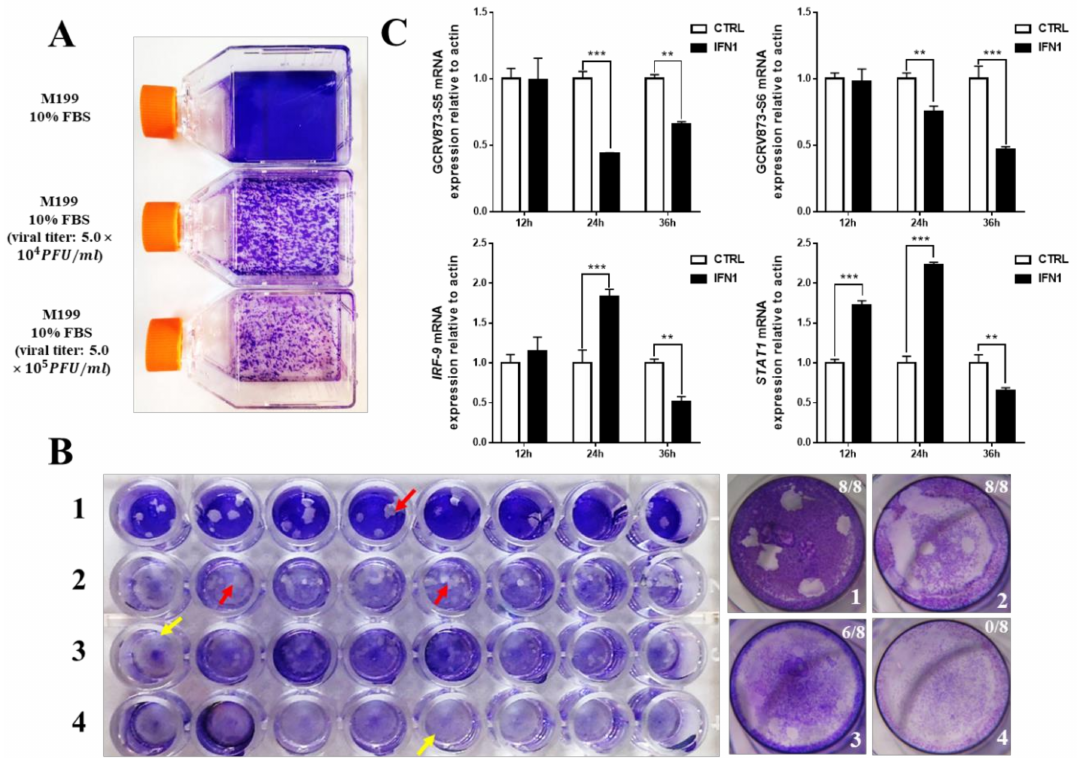
Figure 2. Antiviral ability of grass carp IFN1. ( A ) The pathogenicity of GCRV873 virus particles. The upper bottle contains M199 culture medium supplied with 10% fetal bovine serum; the middle bottle contains M199 culture medium supplied with 10% fetal bovine serum and GCRV873 virus particles at a final concentration of 5.0 × 10 4 PFU/mL; the lower bottle contains M199 culture medium supplied with 10% fetal bovine serum and GCRV873 virus particles at a final concentration of 5.0 × 10 5 PFU/mL. ( B ) The results of crystal violet staining of CIK cells in M199 medium supplied with or without GCRV873 virus particles. 1: CIK cells were infected with GCRV873 (viral titer: 1.0 × 10 2 PFU/mL); 2: CIK cells were electrically transfected with pCDNA3.1 and infected with GCRV873 (viral titer: 1.0 × 10 2 PFU/mL); 3: CIK cells were electrically transfected with pCDNA-IFN1-His and infected with GCRV873 (viral titer: 1.0 × 10 2 PFU/mL); 4: CIK cells were electrically transfected with pCDNA-IFN1-His and not infected with GCRV873. Red arrow: Plaques formed in cultured CIK cells. Yellow arrow: No plaques formed in cultured CIK cells. ( C ) The transcriptional expression of factors in CIK cells infected with GCRV873 (viral titer: 1.0 × 10 2 PFU/mL). S5 and S6 are subunits of GCRV873. IFR-9 and STAT1 are key molecules downstream of type I interferon signaling. Data were expressed as mean ± SD. ** p < 0.01; *** p < 0.001. Next, pcDNA3.1 or pcDNA-IFN1-His plasmids were electrically transfected into CIK cells at about 80% confluence. A final concentration (Viral titer = 1 × 10 2